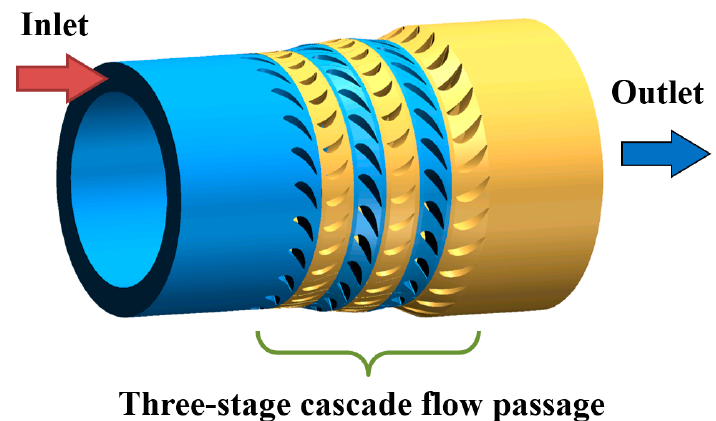
Figure 3. Geometric model of fluid domain.